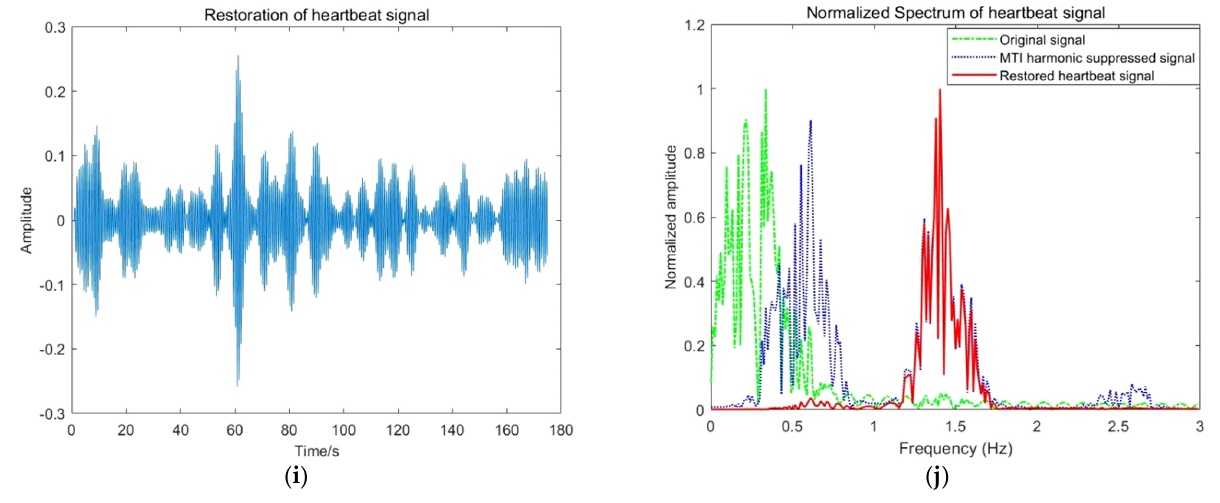
Figure 25. Results of essential steps for experiment group 2: ( a ) Radar raw data; ( b ) Radar data after preprocessing; ( c ) The relative principal component; ( d ) Spatial eigenvector; ( e ) Temporal eigenvector; ( f ) Energy entropy; ( g ) Restoration of respiratory signal; ( h ) Respiratory signal spectrum; ( i ) Restoration of heartbeat signal; ( j ) Heartbeat signal spectrum.